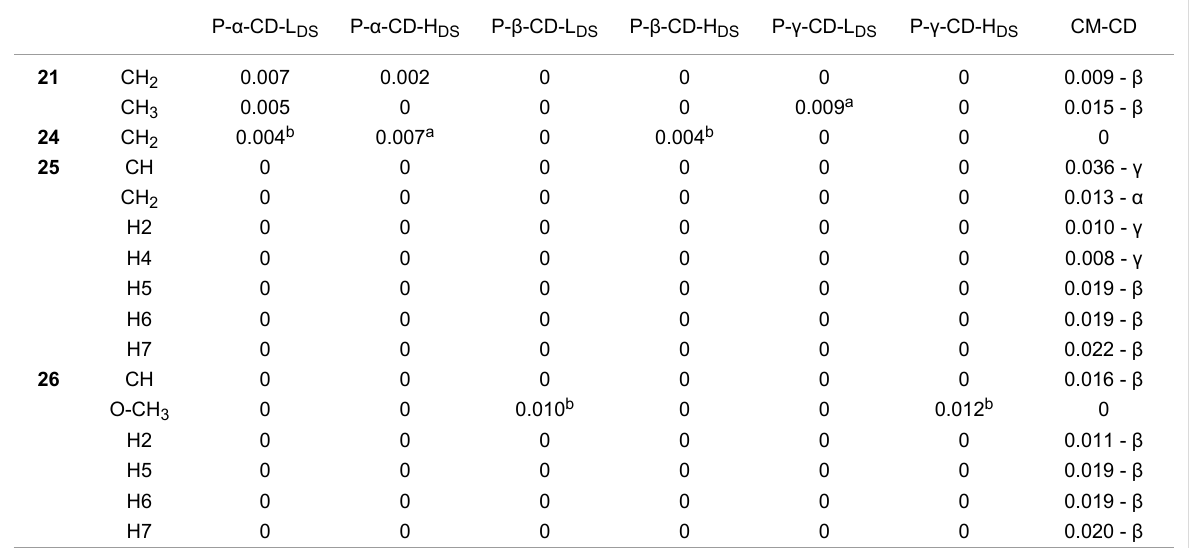
Table 4: Enantiomeric differentiation in ppm in the 1 H NMR spectra (400 MHz) of 21 and 24 – 26 (10 mM) with P-CDs and CM-CD [31] in D 2 O. The concentration of the cyclodextrin is 20 mM unless otherwise